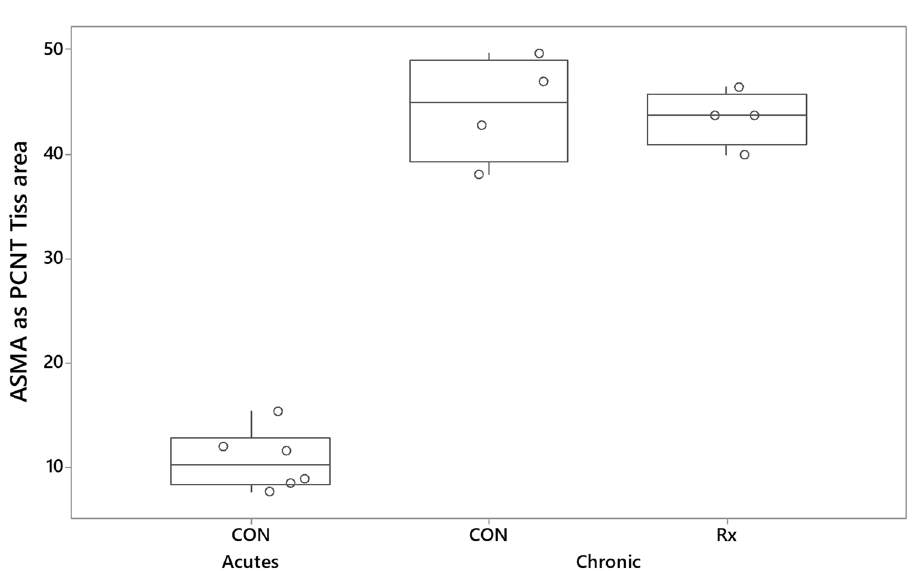
Figure 7. Boxplot illustrating ASMA stain expressed as a percentage of tissue area. The derivation of alpha- smooth muscle actin (ASMA) measurements was as described for Fig. 3. ASMA expression was increased in both radio-exposed (Rx) and contralateral control (CON) lung of sheep undergoing a chronic radiation response, relative to levels seen in the control lungs of sheep undergoing an acute radiation response (CON,